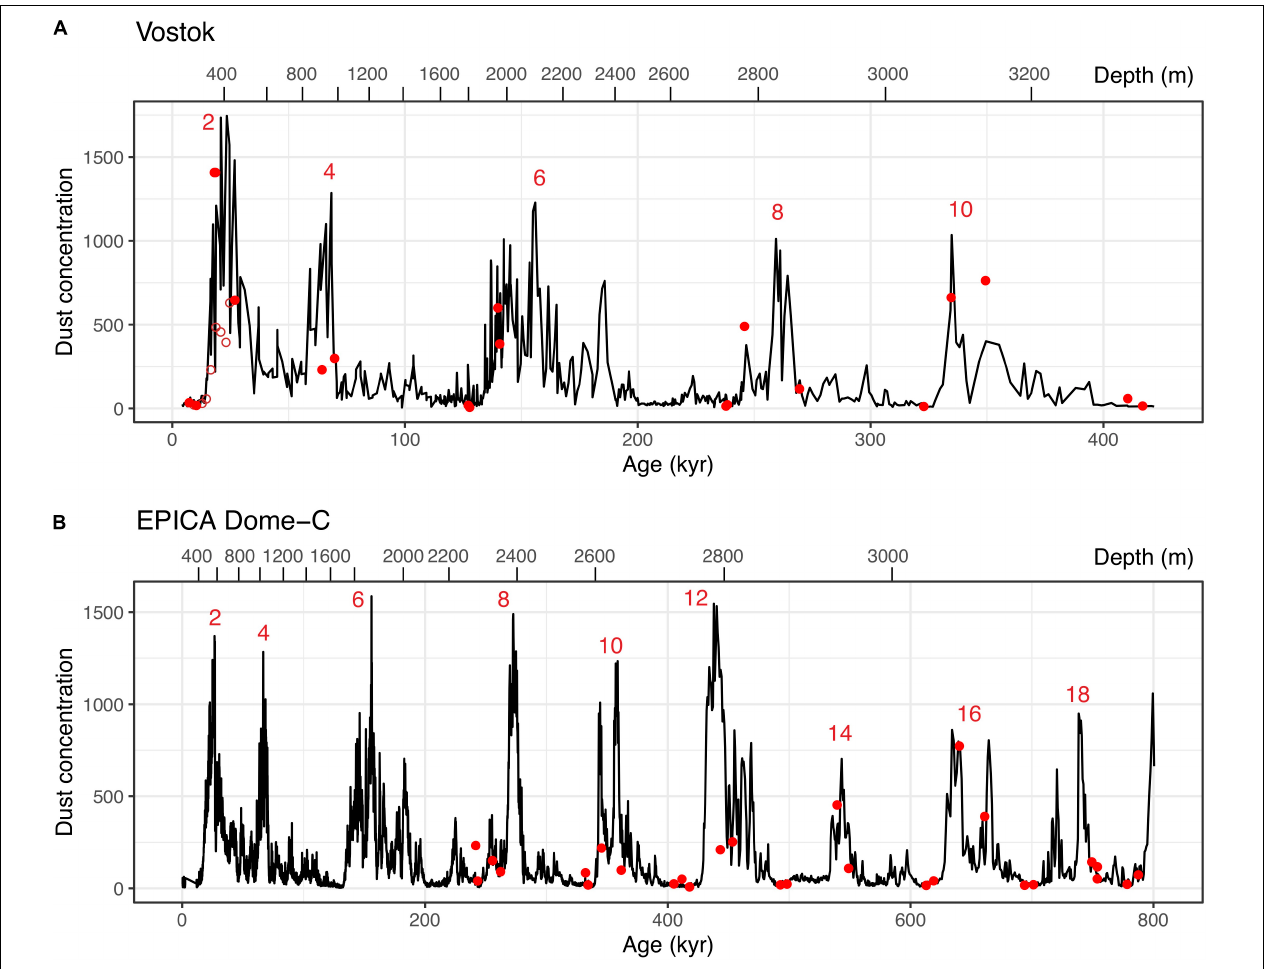
FIGURE 3 | IDC measurements of individual samples (solid red circles) from Vostok and Epica Dome C ( A and B , respectively) compared with extensive measurements on the same cores (black line) from Petit et al. (1999) and Ruth et al. (2008). Vostok samples includes additional samples from Lanci et al. (2007) shown with open symbols, see section “ Appendix .” Red numbers indicate the glacial marine isotopic stages and scales on the top axis report the core depth. Note that all EDC samples are taken at depth > 2,200